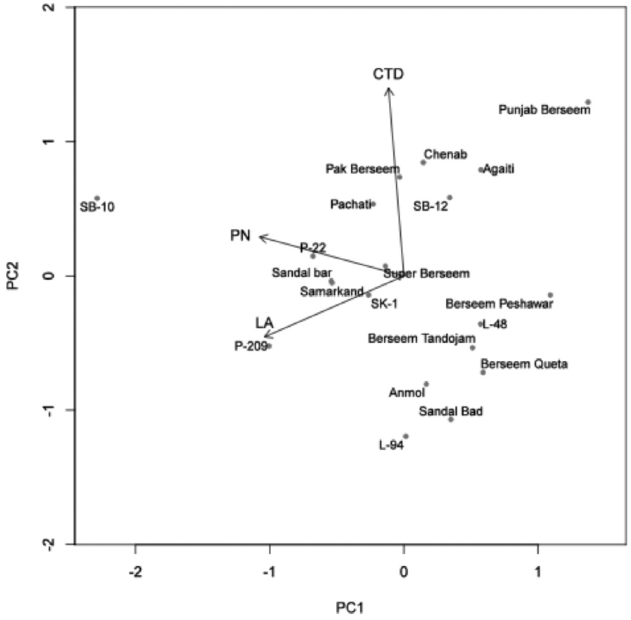
Fig. 4: GGE biplot for standardized net photosynthesis rate (P N ), leaf area (LA), and canopy temperature depression (CTD) under full irrigation for twenty ecotypes of berseem clover ( Trifolium alexandrinum L.). The first principal component axis (PC1) retains 47% and the second 36% of sum of squares of averaged by replications trait-by-ecotypes